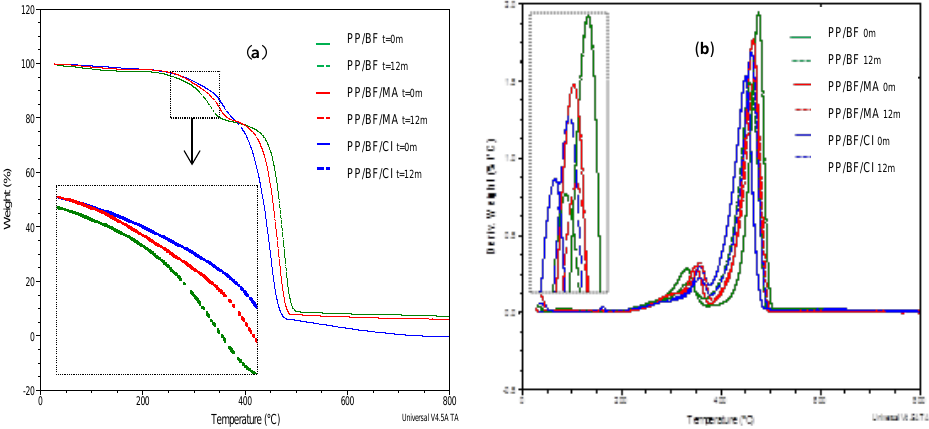
Figure 4. Thermal curves comparative ( a ) thermogravimetric (TGA) and ( b ) derivatives of the thermogravimetric (DTG), of the composites before and after 12 months of natural